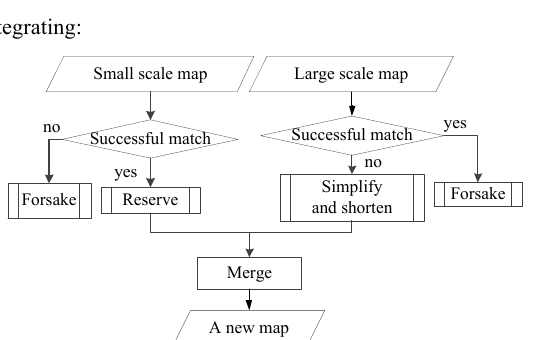
Figure 3: The flow chart of multi-scale maps